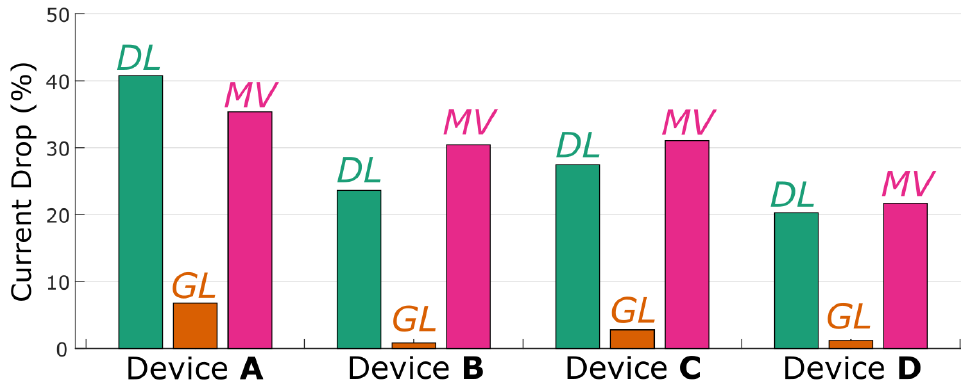
Figure 10. Percentage current drop measured at the MI point by pulsing from GL , DL , and MV points with respect to the value obtained from the ZZ point for devices A – D at T c = 40 ◦